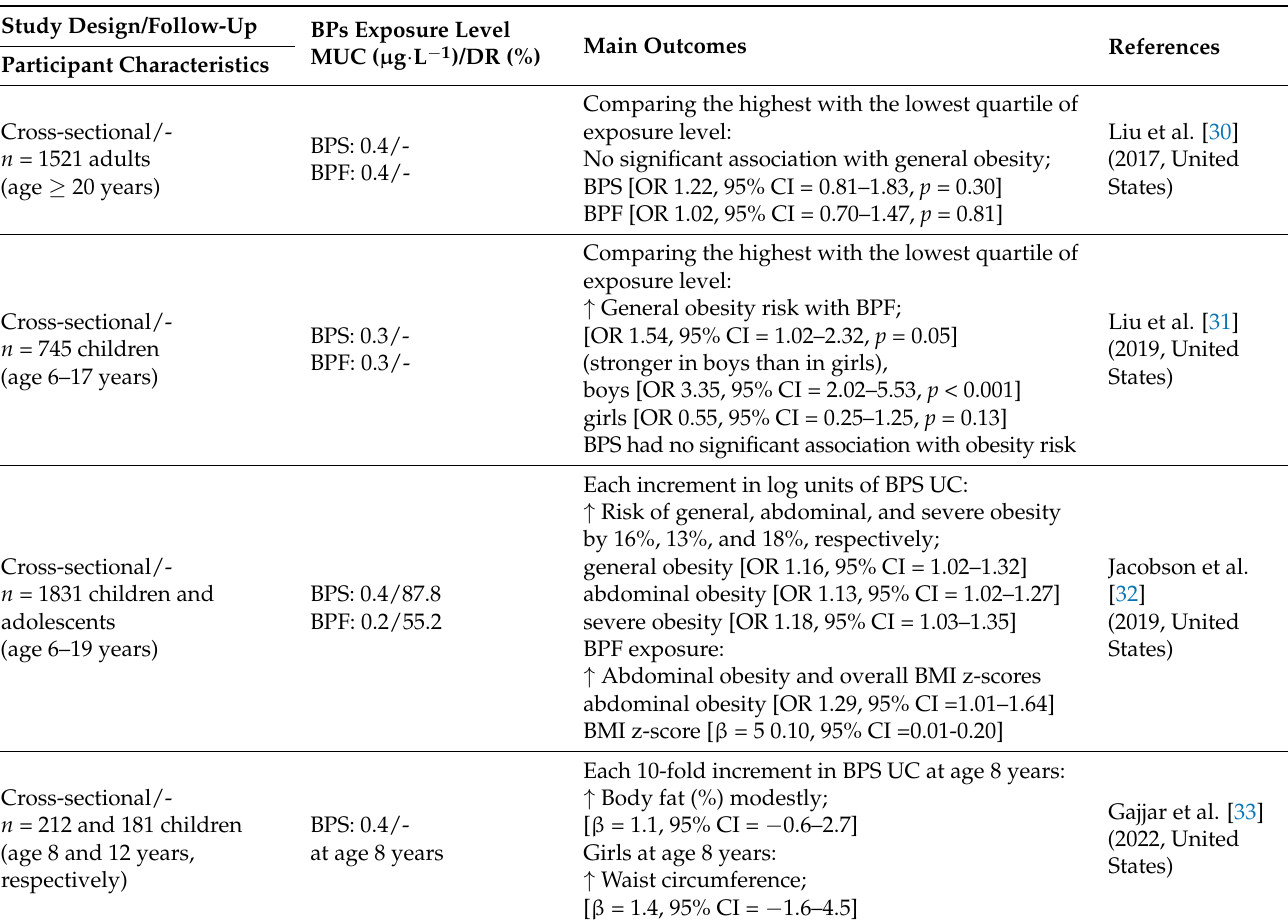
Table 1. Summary of studies reporting the association between BPS and BPF exposure and the incidence of obesity and diabetes in human